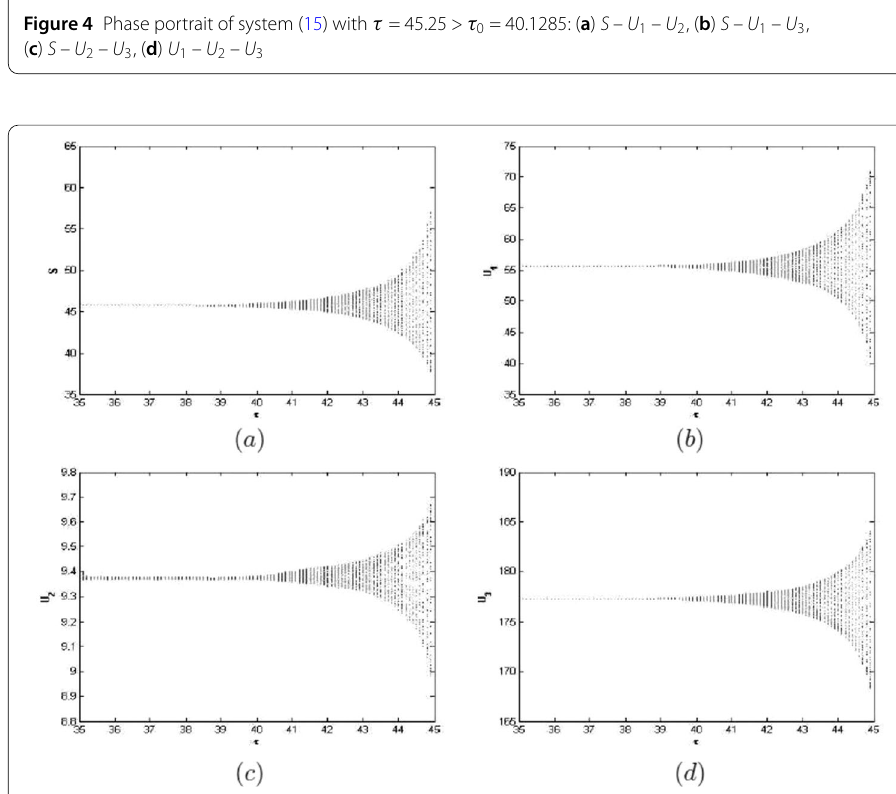
Figure 5 Bifurcation diagram of system (15) with respect to τ : ( a ) S , ( b ) U 1 , ( c ) U 2 , ( d ) U